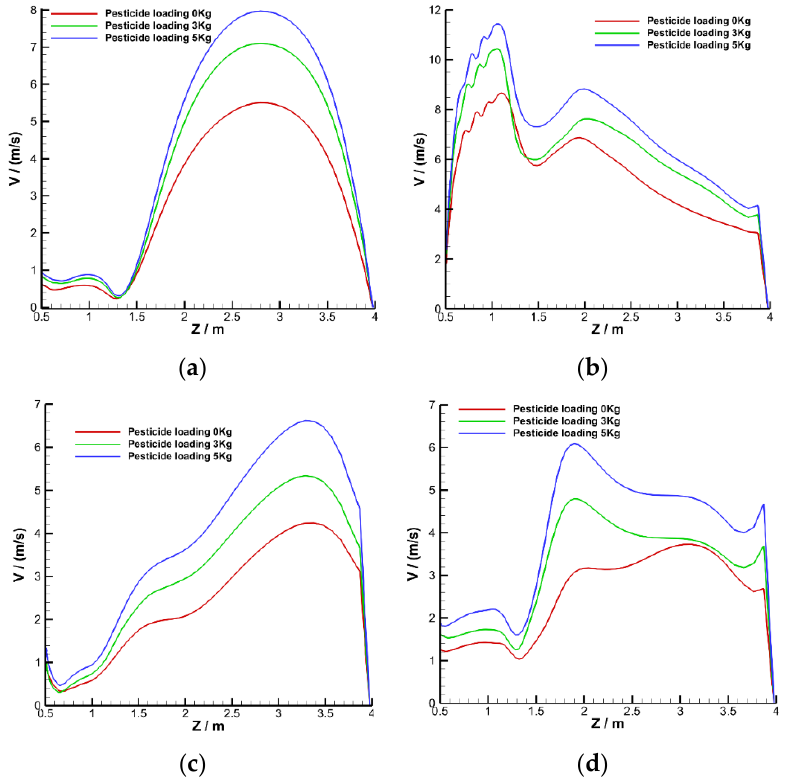
Figure 10. Velocity distribution at various longitudinal line under the different loads: ( a ) Longitudinal line at the geometric center of the UAV; ( b ) Longitudinal line at the geometric center of the rotor; ( c ) Longitudinal line at the airflow inlet of the adjacent rotors; ( d ) Longitudinal line at the airflow outlet of the adjacent